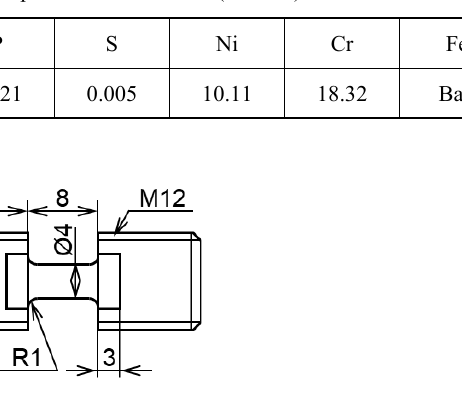
Table 1. Chemical composition of SUS304L (mass %)